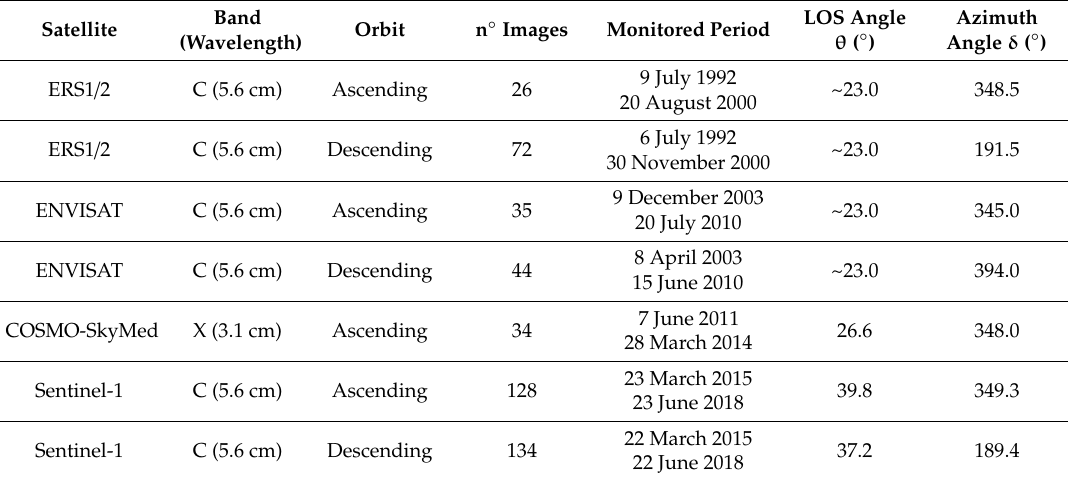
Table 1. Available SAR data for the